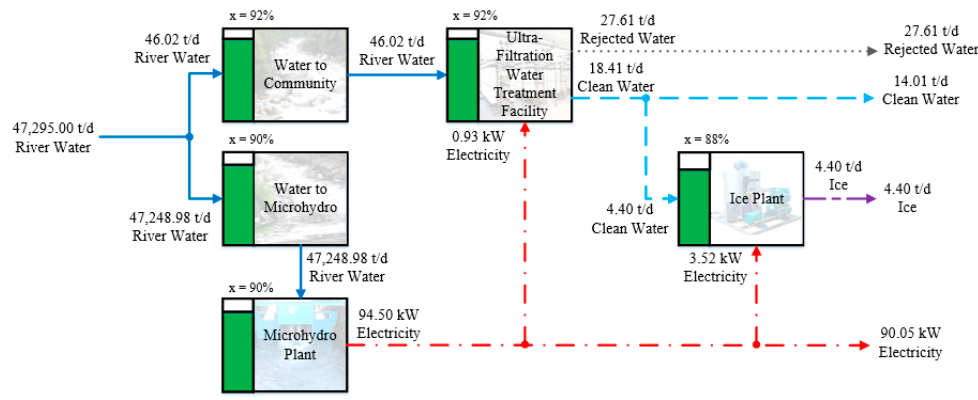
Figure 3. The optimal configuration of the polygeneration system of case study 1 under D = 0.10 (or 10%).